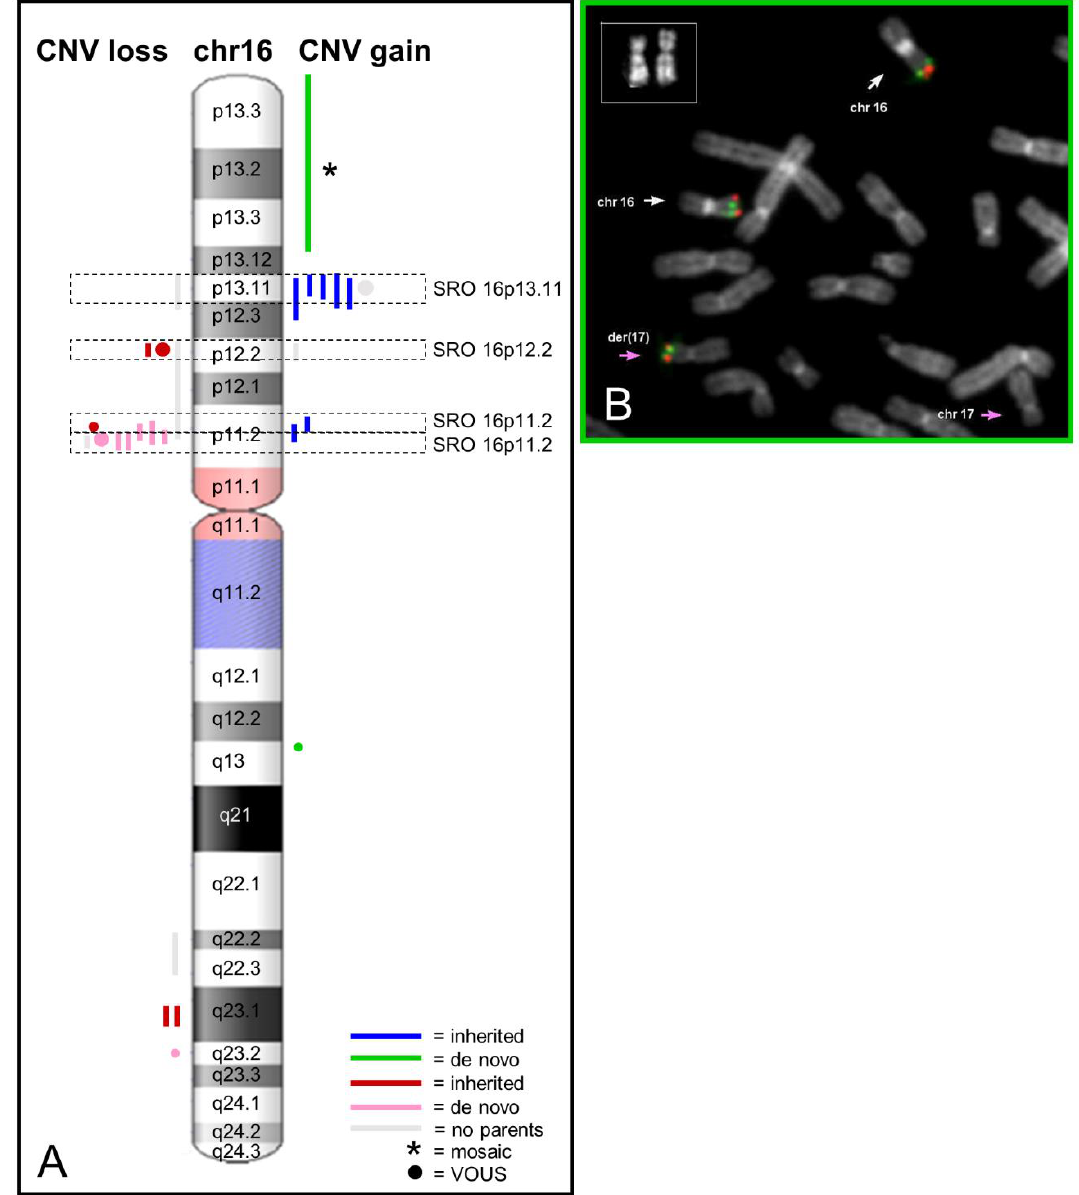
Figure 3. ( A ) Distribution of CNVs among chromosome 16. The dashed boxes show the smallest regions of overlapping (SROs). ( B ) FISH analysis on peripheral blood metaphases of patient 15 with 16p13.3 (red signals) and 16p13.13 (green signals) probes confirmed trisomic 16p13.1–16p13.3 regions. White arrows indicate chromosomes 16 and pink arrows chromosomes 17 (one normal and one with the two signals). 100× magnification.